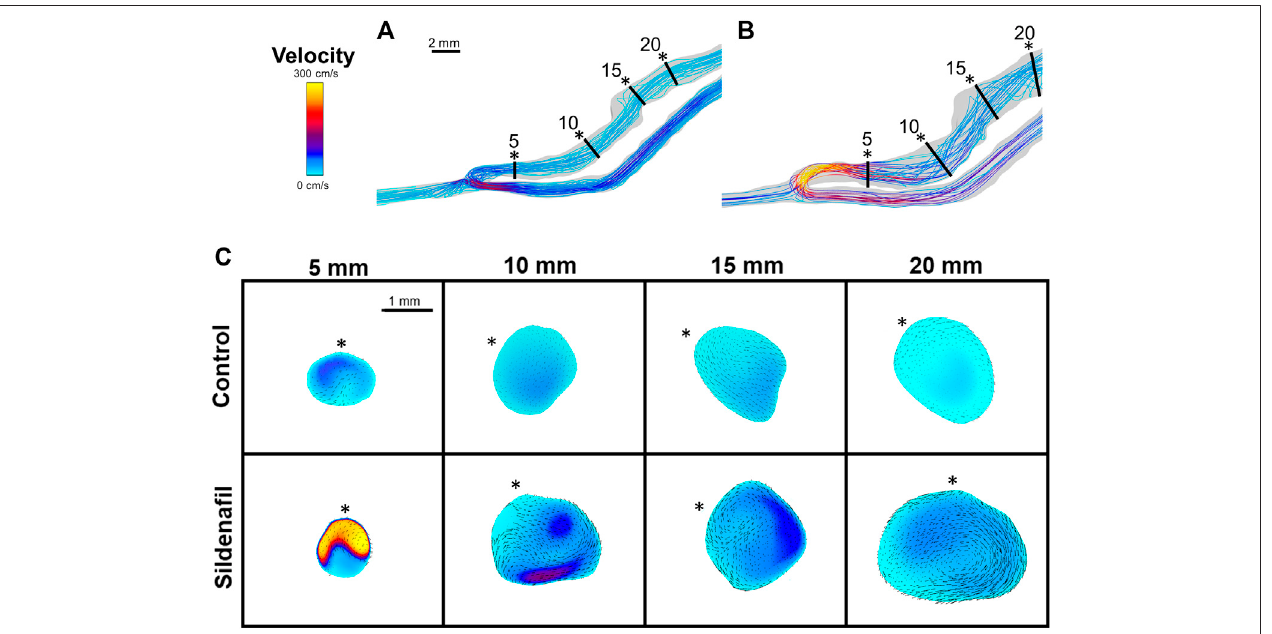
FIGURE 5 | Velocity streamlines and color maps. (A,B) Velocity streamlines for AVFs in a control rat (A) and a sildena fi l treated rat (B). (C) Color maps of velocity magnitude for control (top) and sildena fi l (bottom) treated rats at 5, 10, 15, and 20 mm away from the anastomosis. Black lines in panels A and B represent the slice locations. * in panel C represents the top of the slice as shown in panels A and B. Color bar applies to A-C. Scale bar in A applies to A-B. Black dots/arrows in (C) are velocity vectors.